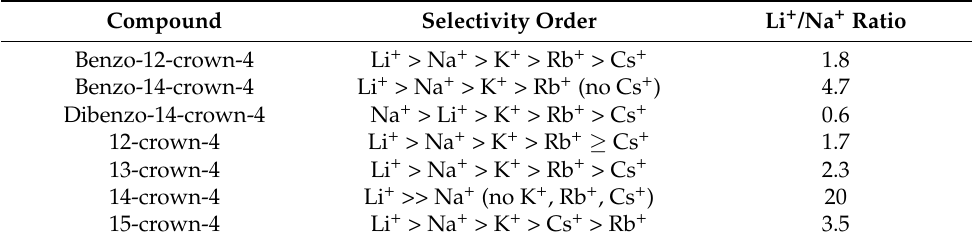
Table 9. Selectivity order of alkali metal cations with respect to various crown ethers [181,184]. Compound Selectivity Order Li + /Na + Ratio